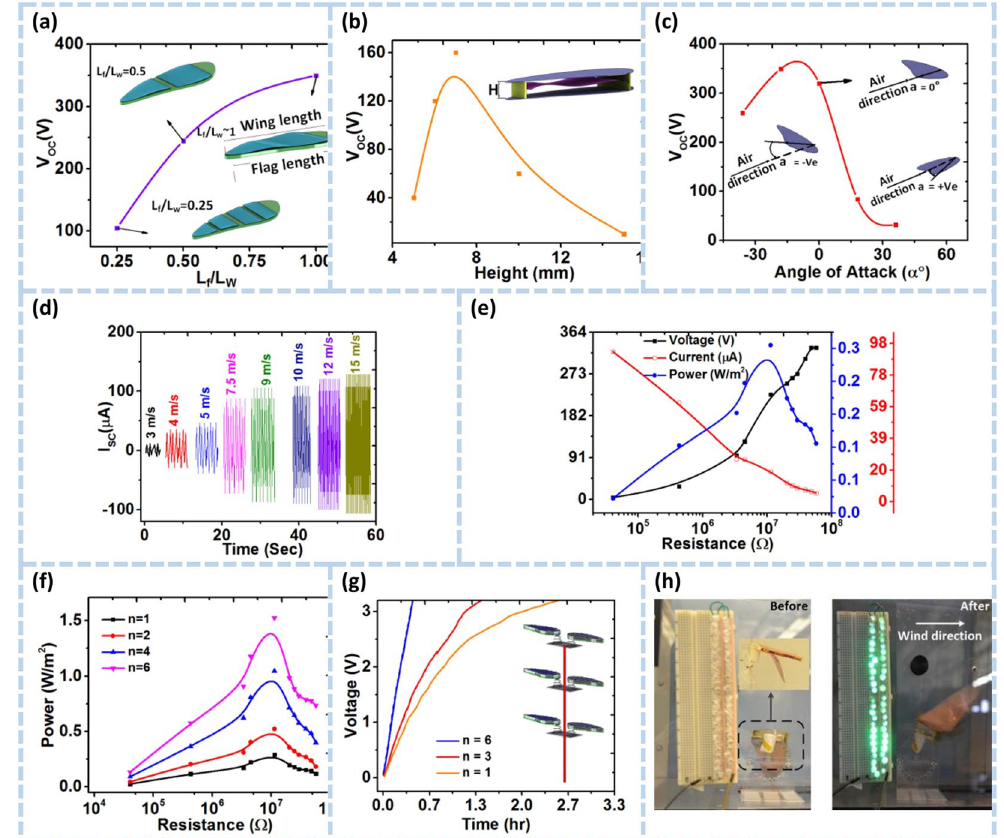
Figure 3. H-TENG characteristic studies. ( a ) Output voltage of the TENG at different flag length ratios. ( b ) The output voltage of the TENG at different heights of the channel inside the wing from 5 mm to 15 mm. ( c ) The output voltage of the TENG at different angles of attack of the channel from − 36° to 36°. ( d ) Dependence of the Short-circuit current, I SC of the H-TENG with varying wind speeds from 3 to 15 m/s. ( e ) Load resistance dependency on the current, voltage and power density for one unit of H-TENG. ( f ) Dependence of the power output with a number of units, n (n = 1, 2, 4 and 6) on the resistance load. ( g ) Charging curves of a capacitor (capacity: 1 µ F) for energy storage by one, three and six hummingbird TENGs. Inset figure is a tree shape network of hummingbird TENG units for portable wind harvesting applications, ( h ) Image of 50 powered LEDs using one unit of the